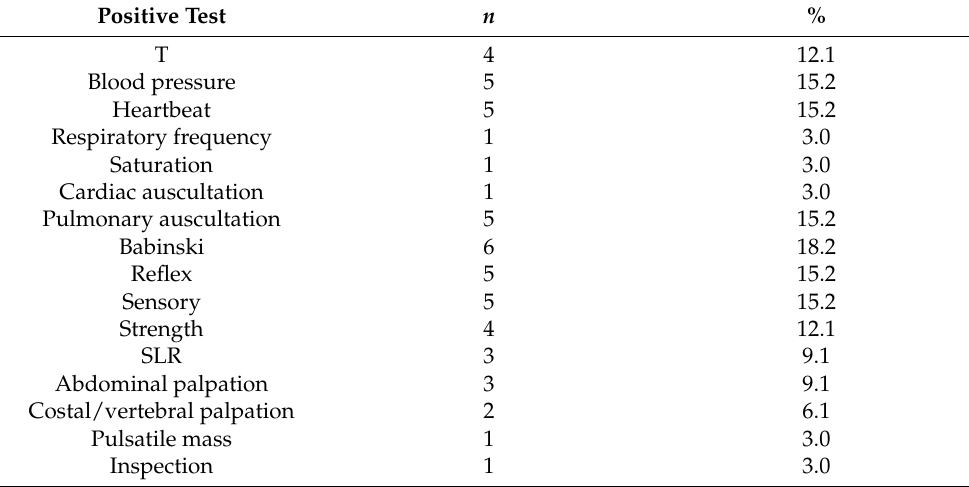
Table 4. Tests that had a positive result in the 26 articles in which a suspicion of serious pathology was